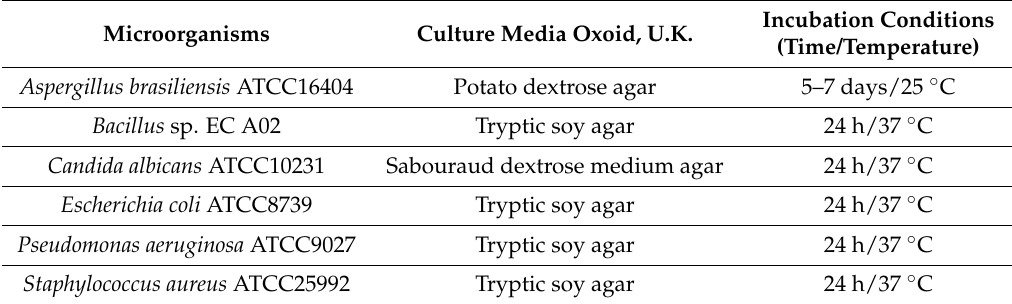
Table 1. Microorganisms used in the study; culture media and incubation